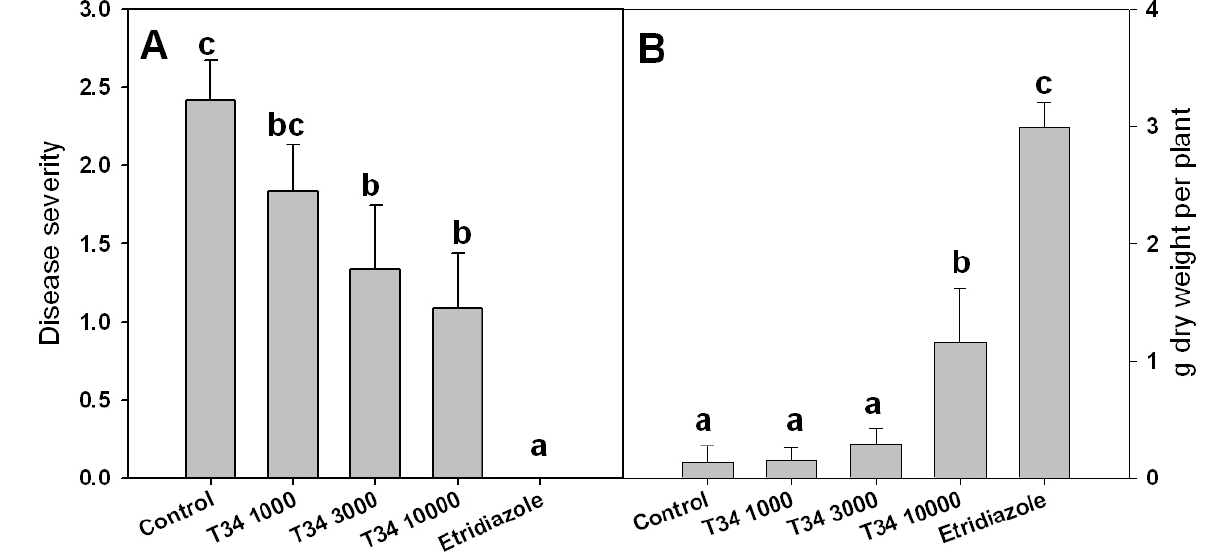
Figure 3 . Disease severity produced by Phytophthora capsici in pepper plants (A) and dry weight of the pepper plants (B) on the last day of the 2010 greenhouse experiment (21 d after inoculation with the pathogen). Disease severity was scored using the following symptom scale: 0, healthy plant; 1, less than half the leaves wilted; 2, more than half the leaves wilted; and 3, dead plant. Control, water; T34 1,000, 3,000 and 10,000, Trichoderma asperellum strain T34 at 10 3 , 3 × 10 3 and 10 4 conidia mL -1 ; Etridiazole, Terrazole ® at 2 L ha -1 . Treatments were applied at the same time as the pathogen and a second treatment was applied on detection of symptoms of disease. Different letters indicate significant differences within treatments, Dun - can’s multiple range test ( P